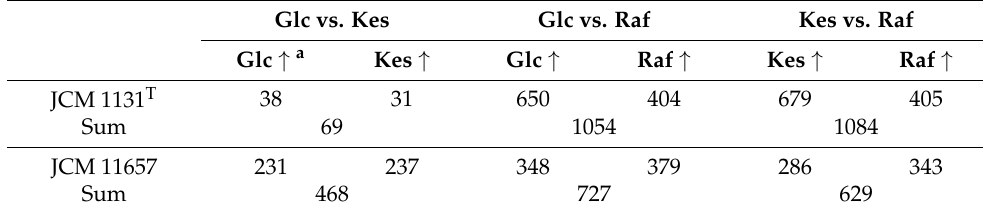
Table 2. Number of upregulated genes in each Cluster of Orthologous Group (COG) class by the presence of different carbo- hydrates. All CDSs a Glc 2 Glc vs. Kes Glc Glc vs. Raf Kes vs.